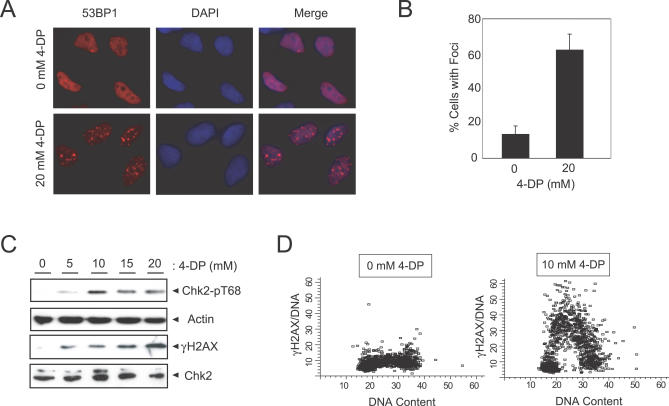
Inhibition of Pdxk Causes DSBs in Human Cells(A) HeLa cells display elevated levels of 53BP1 foci following inhibition of Pdxk by 4-DP.(B) Quantitation of cells with 53BP1 foci following 4-DP treatment.(C) 4-DP treatment activates the DNA damage checkpoint in HeLa cells as measured by Chk2 phospho-Thr68 and γ-H2AX immunoblotting.(D) SiHa cells treated with 4-DP accumulate γ-H2AX in S-phase, as measured by flow cytometry.